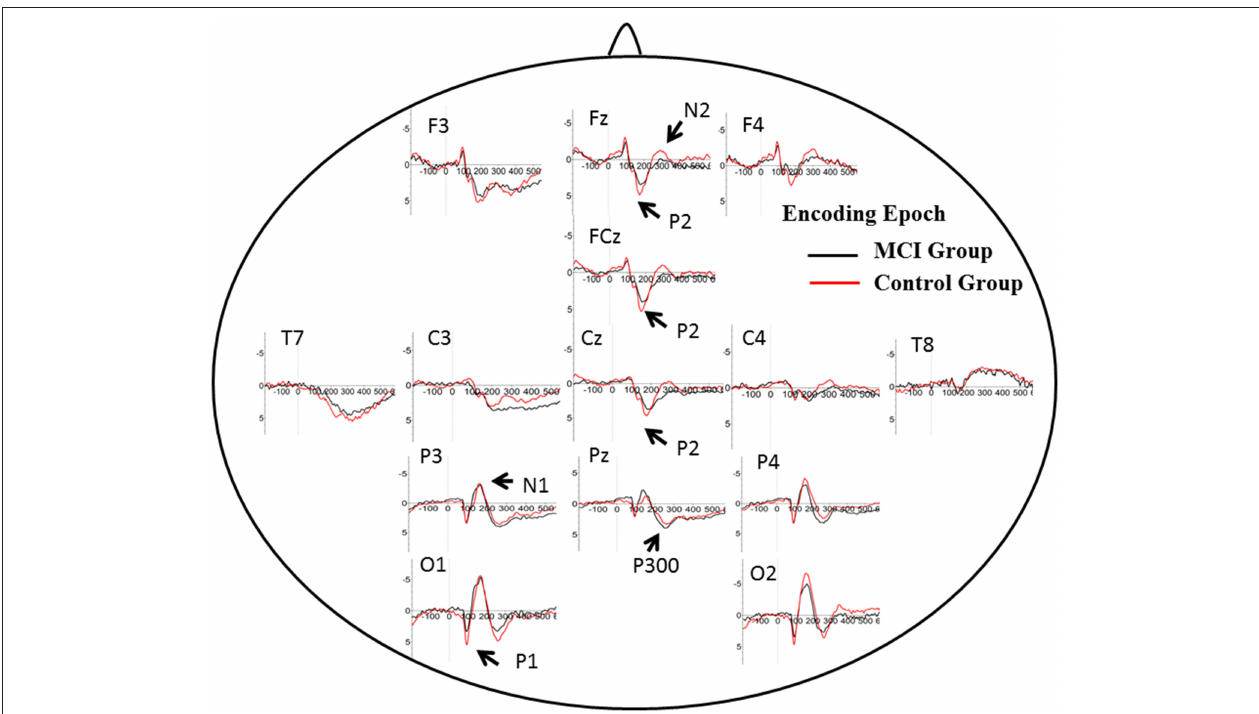
FIGURE 2 | Grand average ERP waveform in aMCI (black line) and normal control group (red line) during retrieval period in WM task. Time was shown in milliseconds where stimulus onset was at 0, and potentials were shown in micro-voltage.